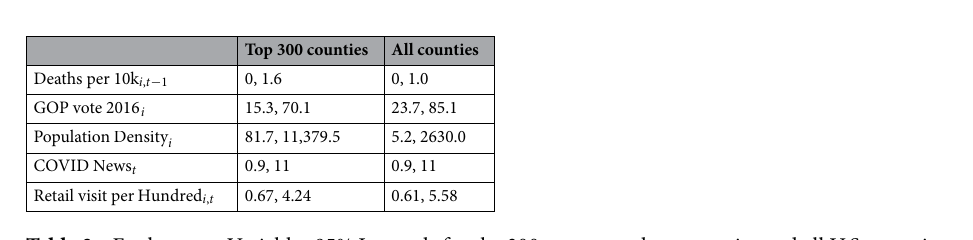
Table 3. Explanatory Variables 95% Intervals for the 300 most populous counties and all U.S. counties.